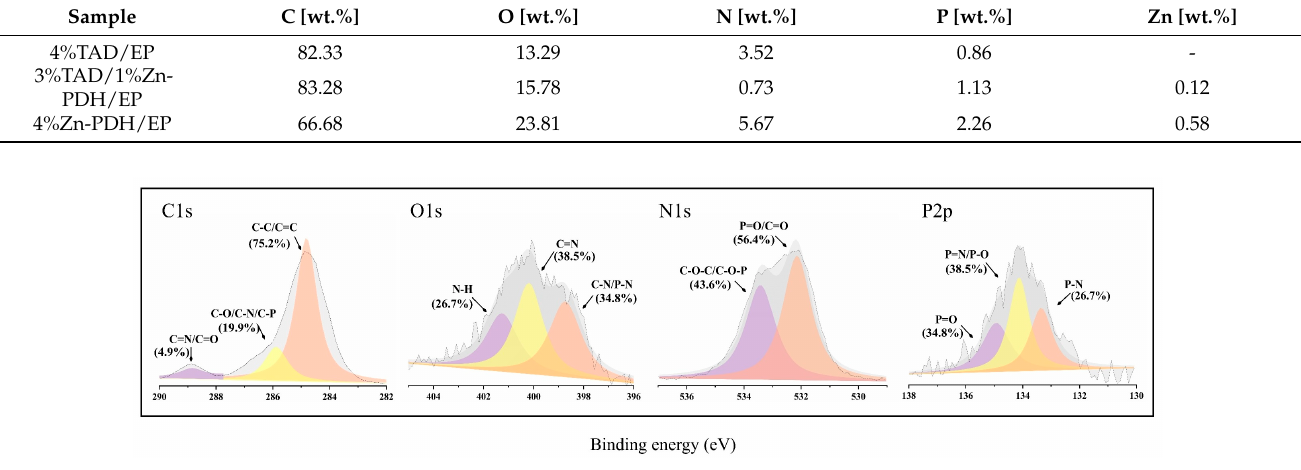
Figure 8. XPS spectra of residual carbon after cone size test of EP composites: C1s, O1s, N1s, and P2p. Table 6. Carbon residue data of EP composites after cone size test from XPS.